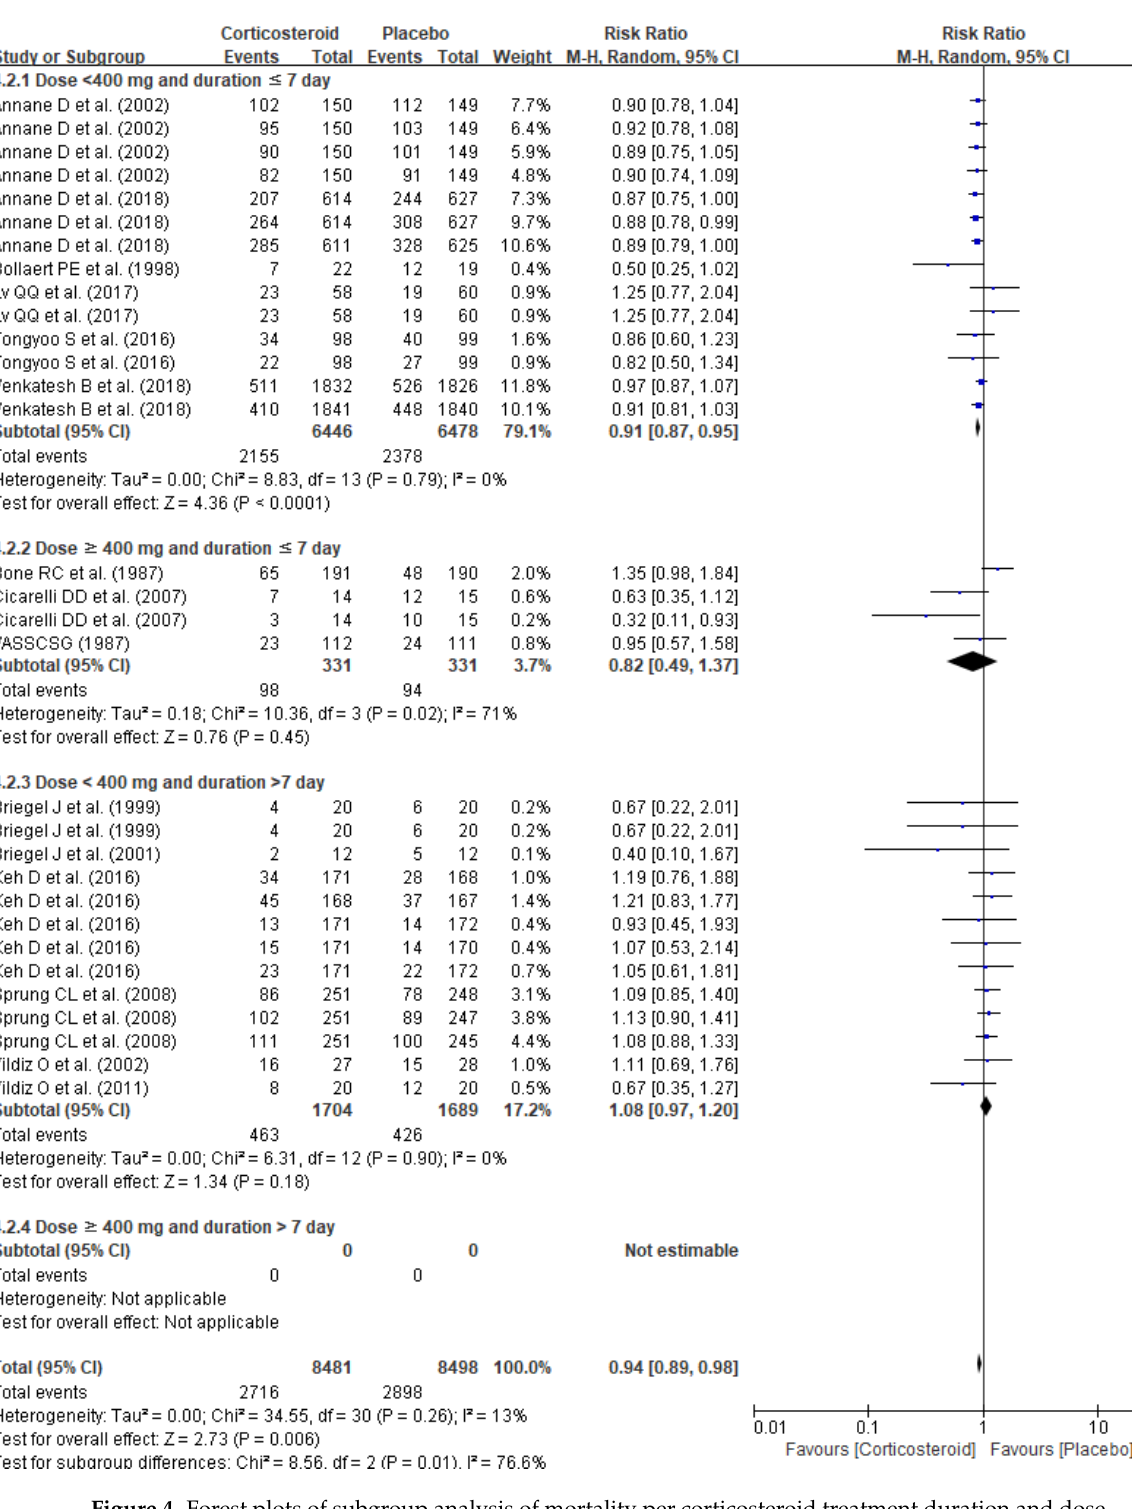
Figure 4. Forest plots of subgroup analysis of mortality per corticosteroid treatment duration and dose.